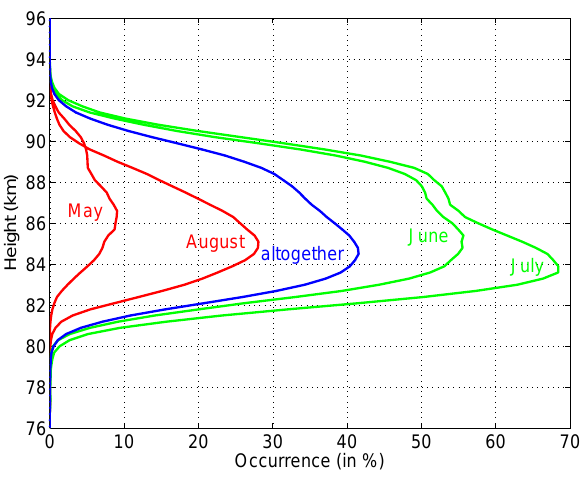
Fig. 8. Mean height dependence of the PMSE occurrence rate (av- eraged over five years) for the periods May and August (red), June and July (green), and the complete summer season